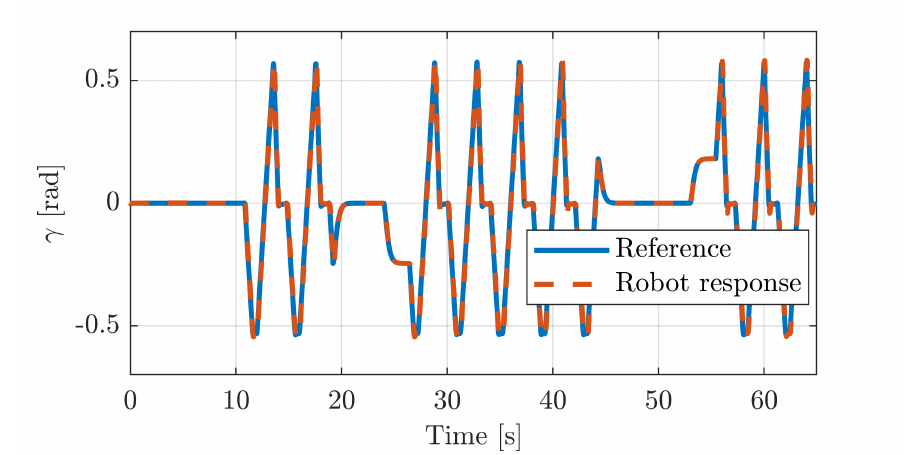
Figure 15. Pitch evolution with alarm activation in the Simulink model of the